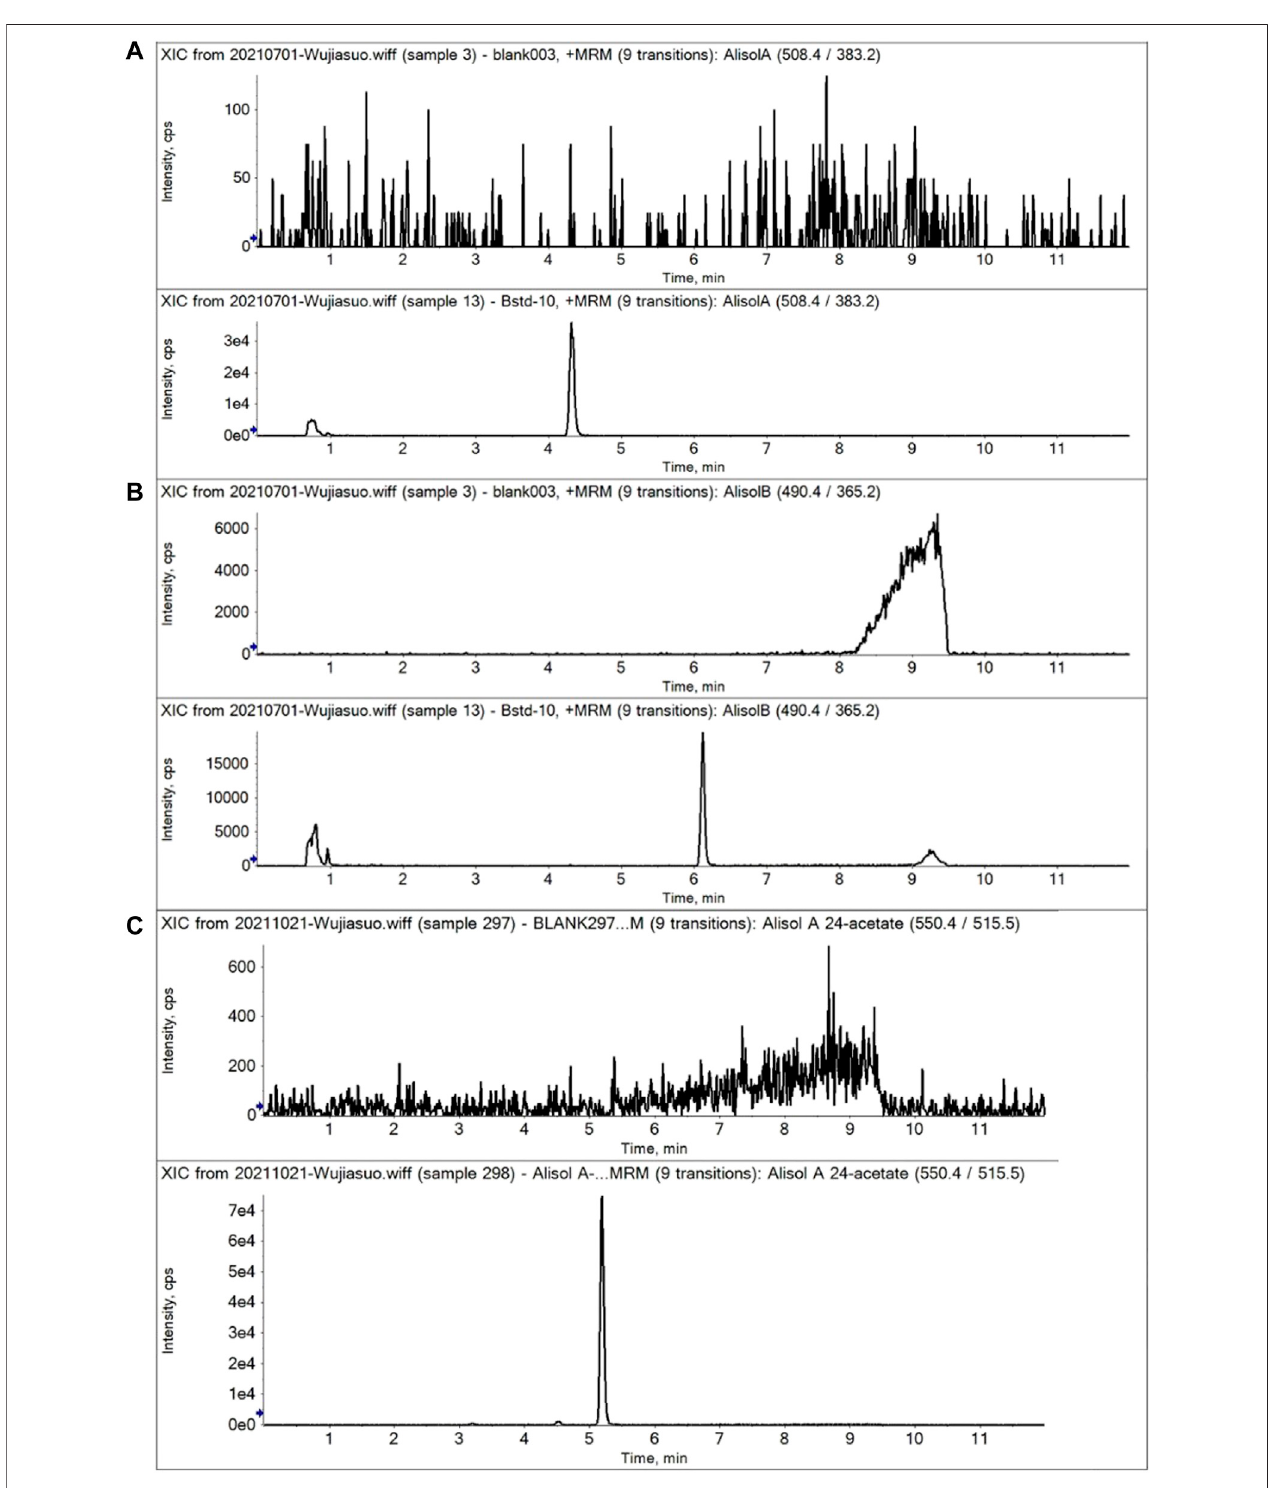
FIGURE2| RepresentativeMRM chromatogramsofalisolA,alisolB,andalisolA24-acetateinplasmasamples. (A) .AlisolA; (B) .AlisolB; (C) .AlisolA24-acetate. (Up-down, blank plasma and that spiked three analytes).